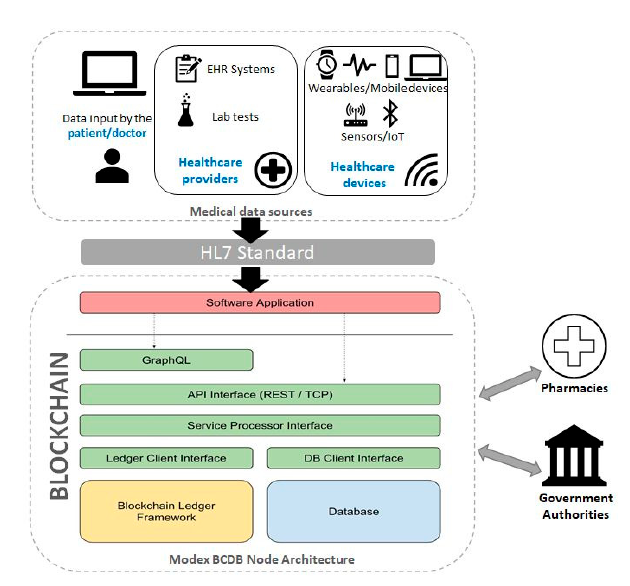
Figure 5. PatientDataChain architectural model .